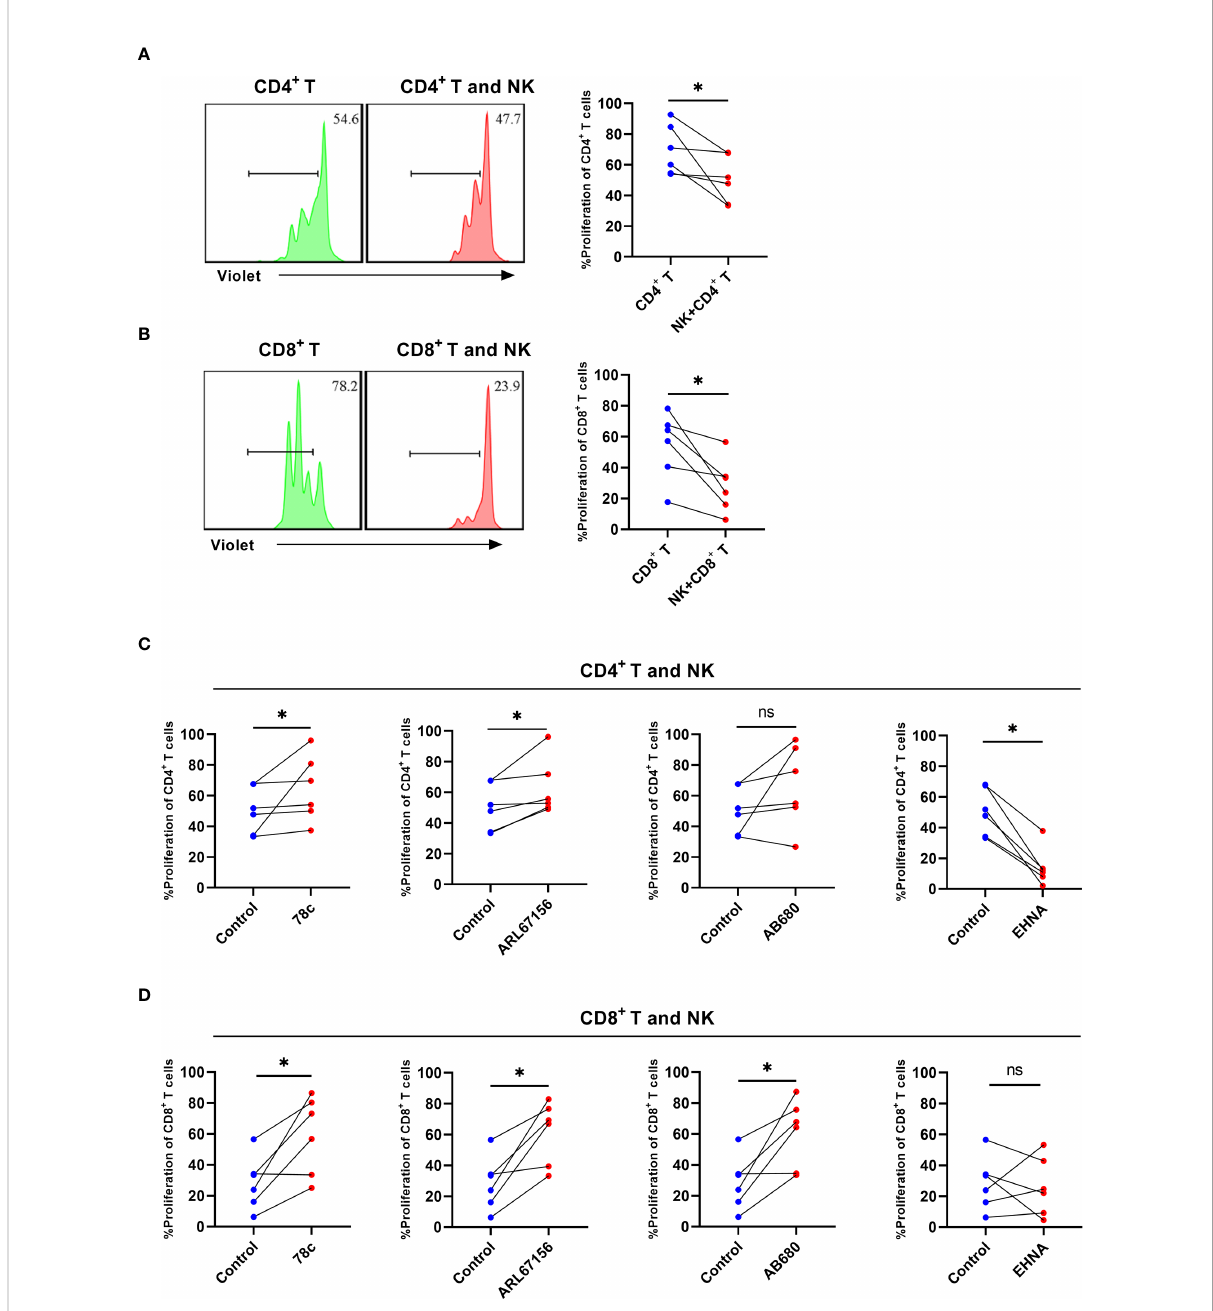
FIGURE 6 NK cells from HIV infected individuals inhibit the proliferation of CD4 + T and CD8 + T cells and CD38, CD39, and CD73 inhibitors reverse the effect. (A) A representative histogram and comparison showing the proliferation of CD4 + T cells with or without autologous NK cells for 3 days. (B) A representative histogram and comparison showing the proliferation of CD8 + T cells with or without autologous NK cells for 3 days. (C) Comparison of the proliferation of CD4 + T cells cultured with NK cells from untreated HIV infected individuals stimulated with 78c, ARL67156, AB680, and EHNA. (D) Comparison of the proliferation of CD8 + T cells cultured with NK cells from untreated HIV infected individuals stimulated with 78c, ARL67156, AB680 and EHNA. *p < 0.05, ns: no signi fi